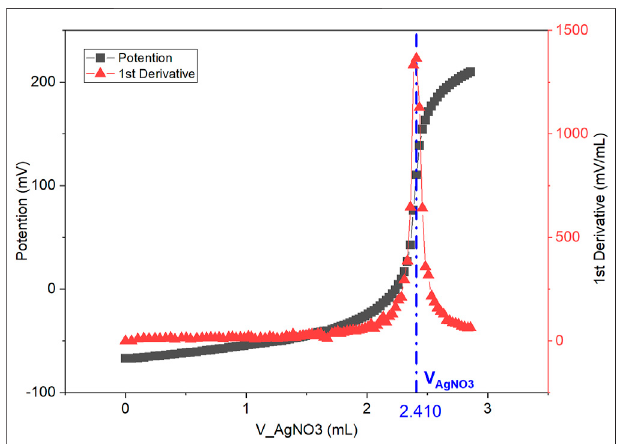
FIGURE 2 | Titration curve of Ag ISE potential (mV) over AgNO 3 titrant volume (ml) is denoted as black squares. First derivative of potential over volume, mV/mL vs. mL is denoted as red triangles. The maximum at V AgNO3 (2.410 ml) is the titration endpoint. AEM sample dry weight is measured as m dry = 24.4